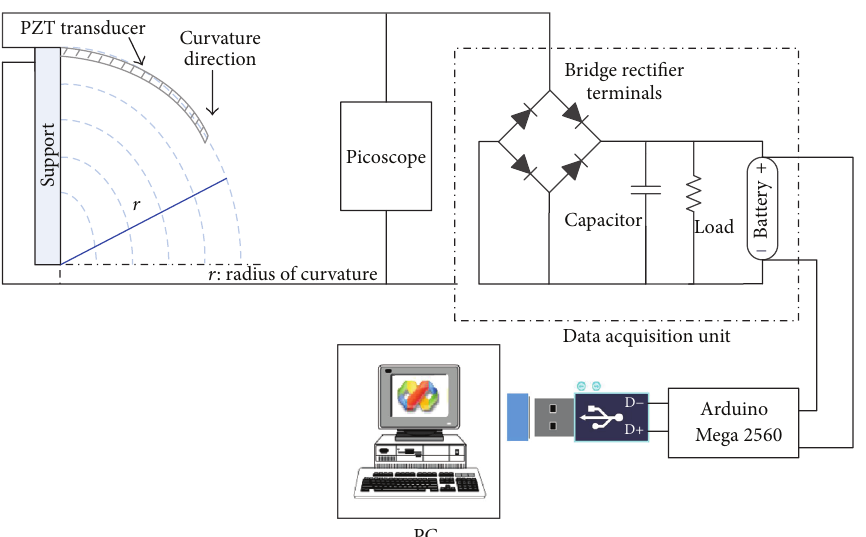
Figure 2: Experimental setup depicting the method of data acquisition from the flexible PZT piezoelectric transducer.